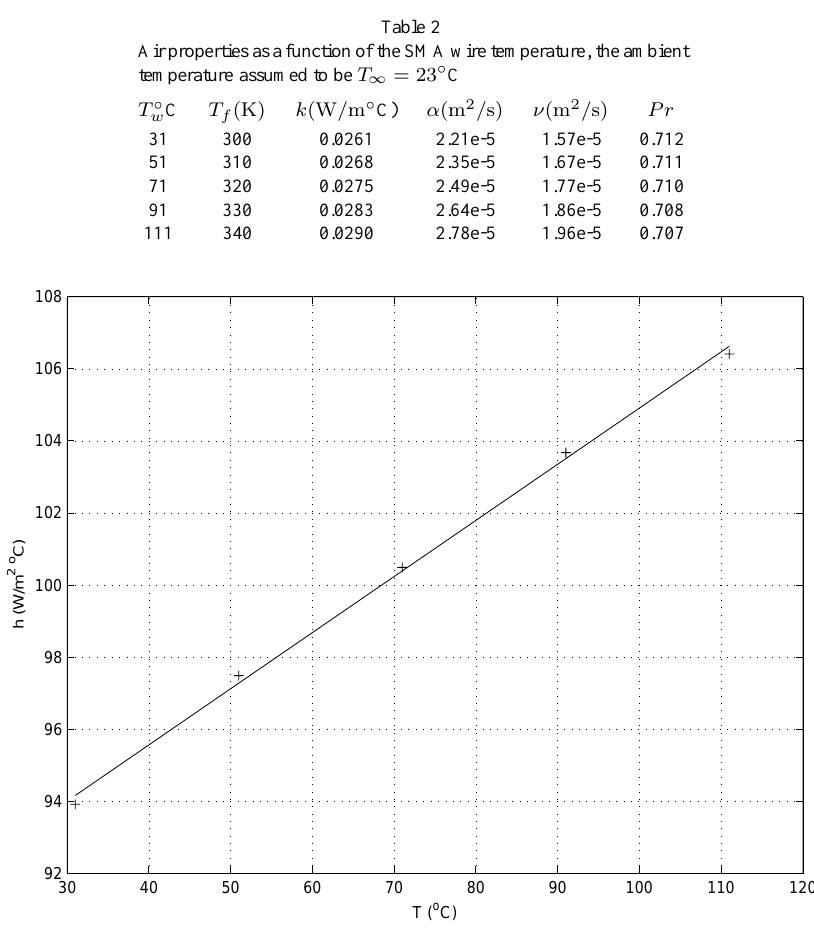
Fig. 12. The convection heat transfer coefficient as the function of the SMA wire